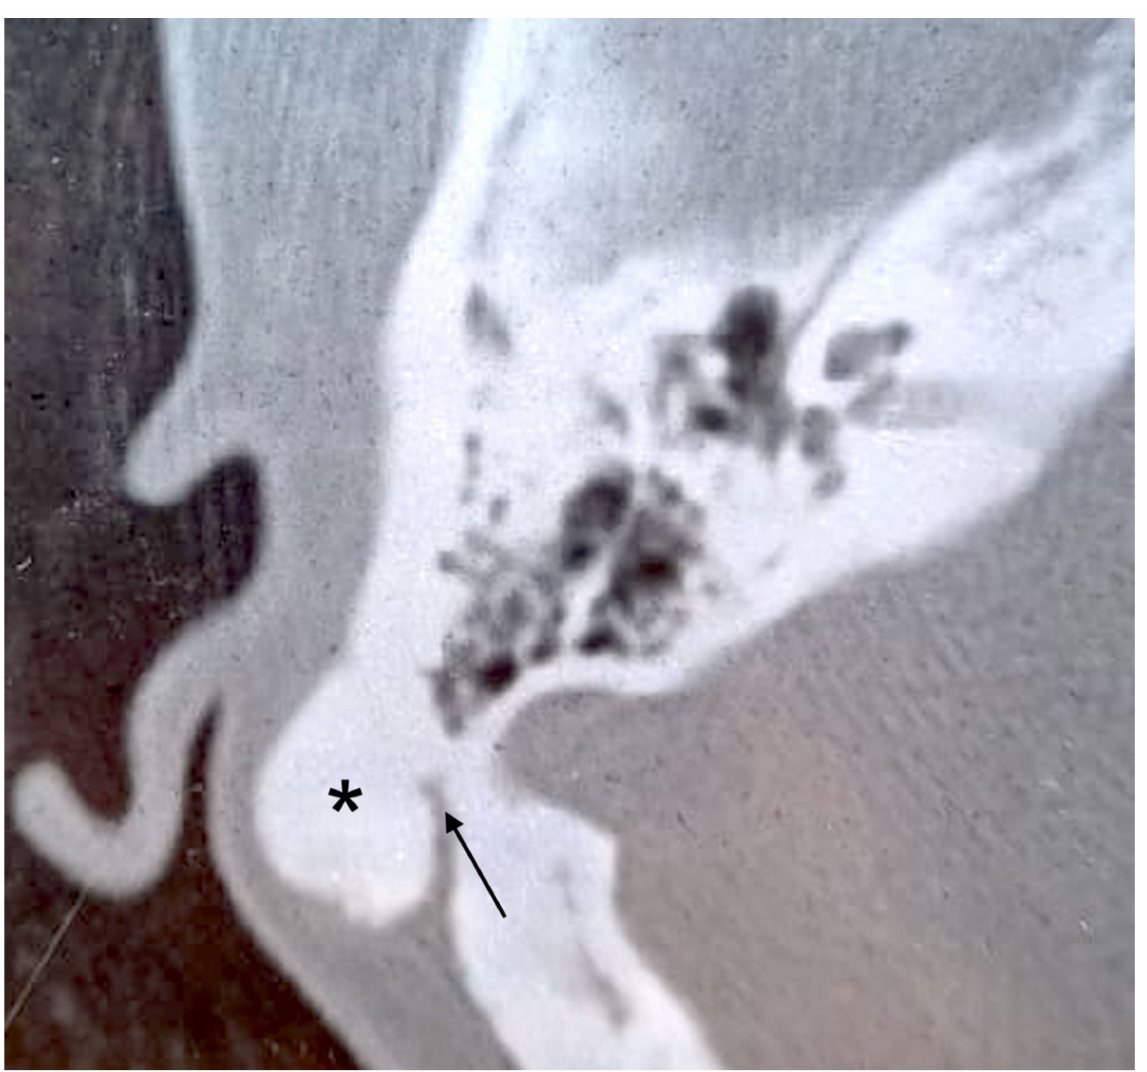
Figure 1. Axial CT scan. Pedicled bony mass (asterisk) arising from mastoid cortex of the right side. The pedicle is indicated by the